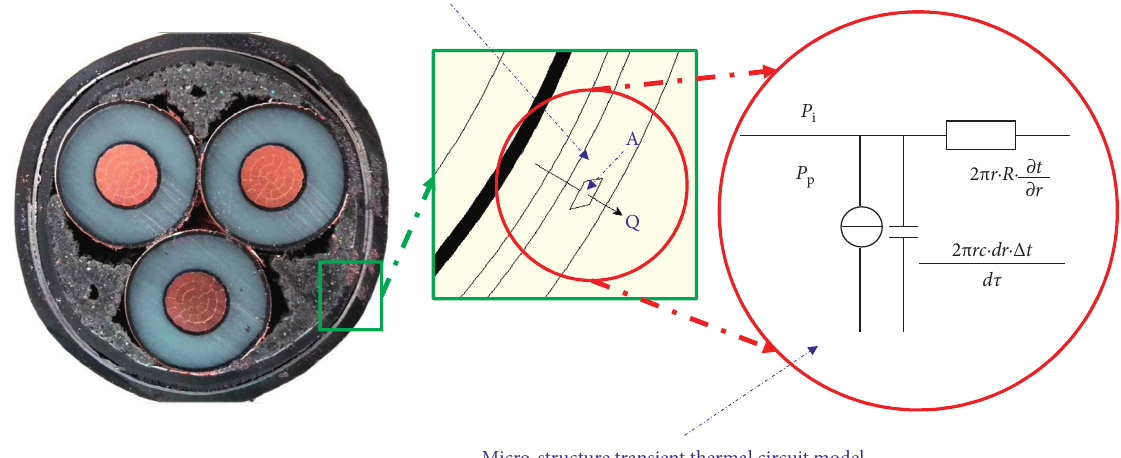
Figure 3: Transient thermal circuit model of cable sheath with microelement distributed